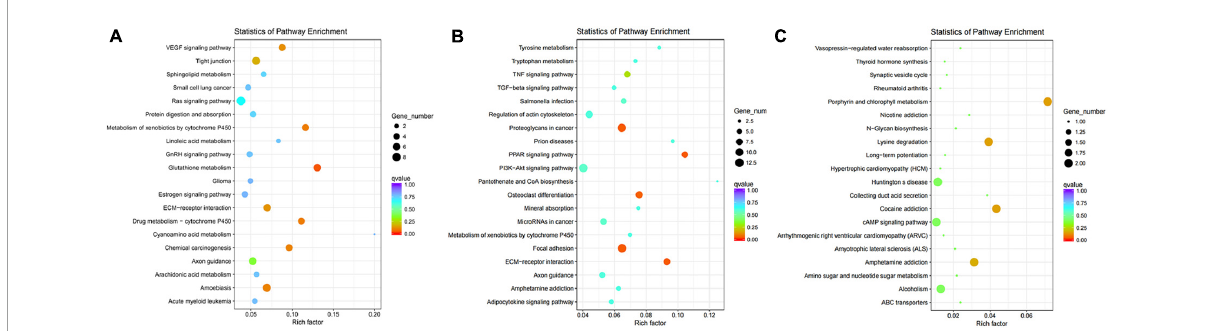
FIGURE4 Kyoto encyclopedia of genes (KEGG) pathways enrichment scatter plot of DEGs. (A,B) The KEGG pathways of WGP_b1 to WGP_b2. (C) The KEGG pathways of WGP_w1 to WGP_w2. The vertical axis represents pathway name, and the horizontal axis represents Rich factor. The size of dots represents the number of differentially expressed genes in this pathway, and the color of dots corresponds to different Q -value ranges. The redder the color, the more significant the